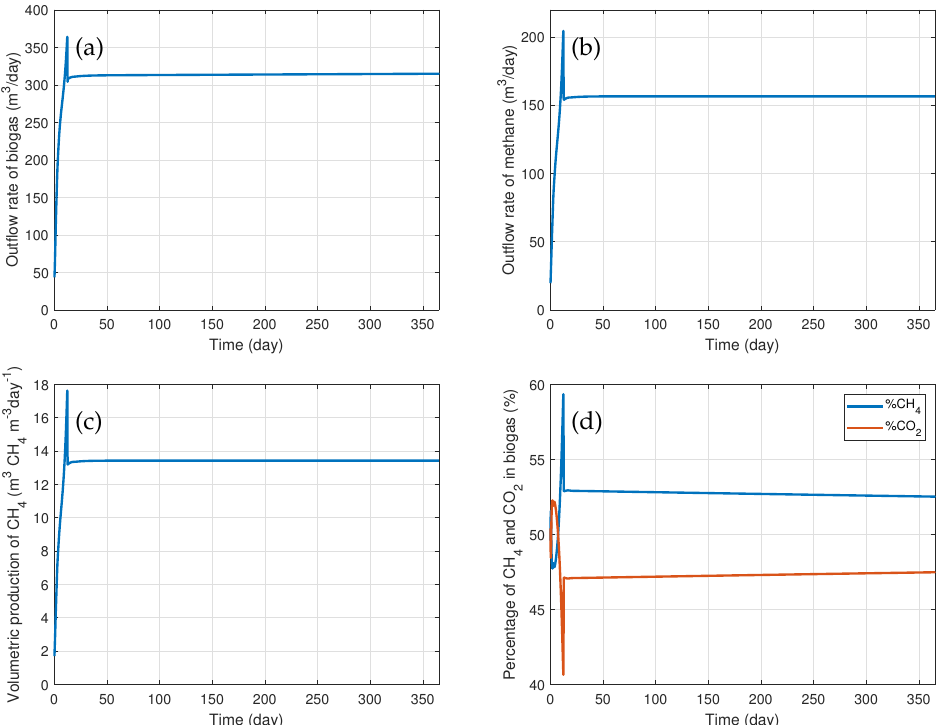
Figure 10. Anaerobic digestion: ( a ) Outflow rate of biogas. ( b ) Outflow rate of methane. ( c ) Volumetric production of methane. ( d ) Methane percentage in biogas.